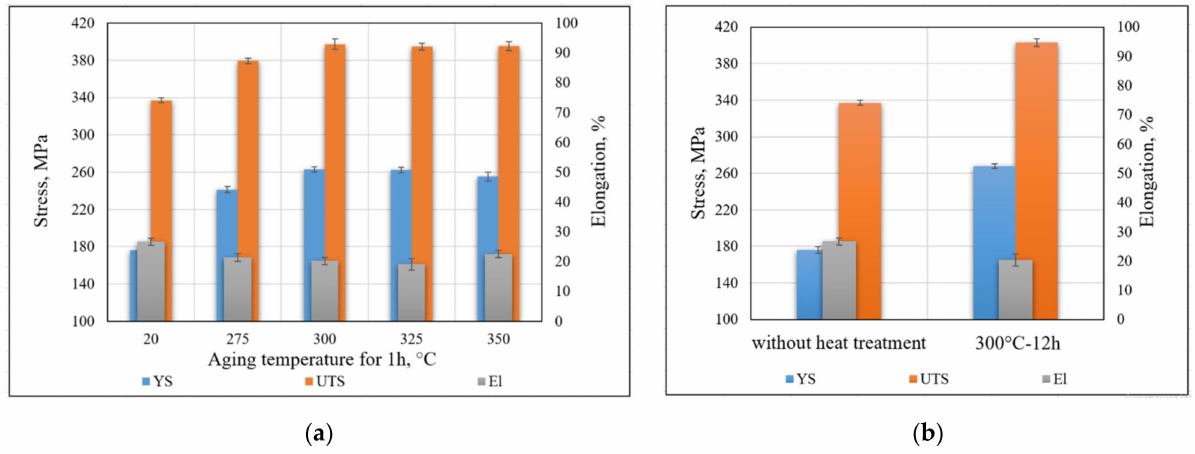
Figure 10. ( a ) Mechanical properties at various temperatures for 1 h aging; ( b ) maximum strength properties due to heat treatment.